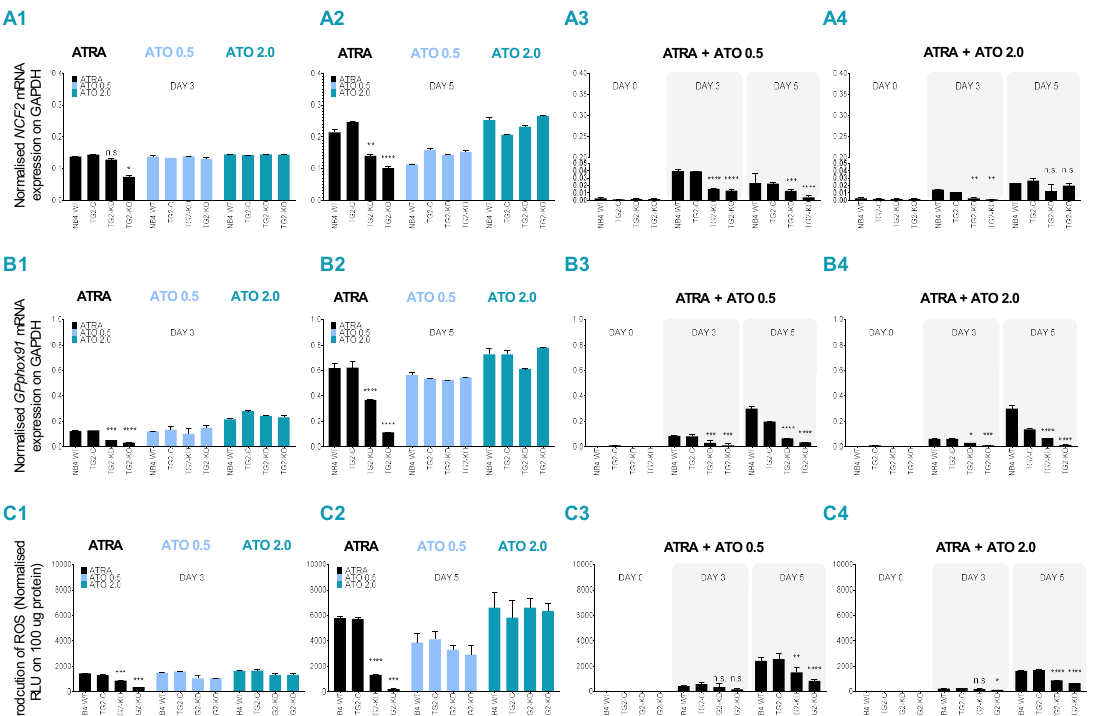
Figure 2. Combined ATRA + ATO treatment attenuates both expression of NCF2 and GPPHOX91 respiratory burst oxidase genes and the production of reactive oxygen species. ( A1 – A4 ) NB4 WT, Table. TG2-KD and TG2-KO cells were incubated with 1 µ M ATRA, ATO (0.5 µ M or 2.0 µ M) and a combination of the two ( A3 – A4 ) for three ( A1 ) and for five days ( A2 ). Relative mRNA expressions of NCF2 / P67PHOX were measured on the indicated days by real-time Q-PCR and were normalized to GAPDH . The graph represents relative mRNA expression (means ± SD, n = 3). Statistical significance was determined via two-way analysis of variance (ANOVA; Bonferroni post-hoc test; NB4 WT vs. TG2-KD, TG2-KO * p < 0.05, ** p < 0.01 and *** p < 0.001, **** p < 0.0001). (B1 – B4 ) NB4 WT,